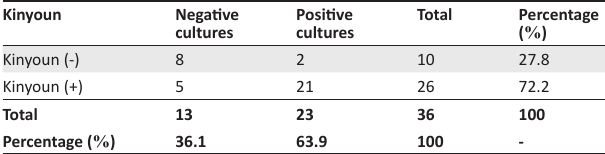
TABLE 4: Positive cultures from